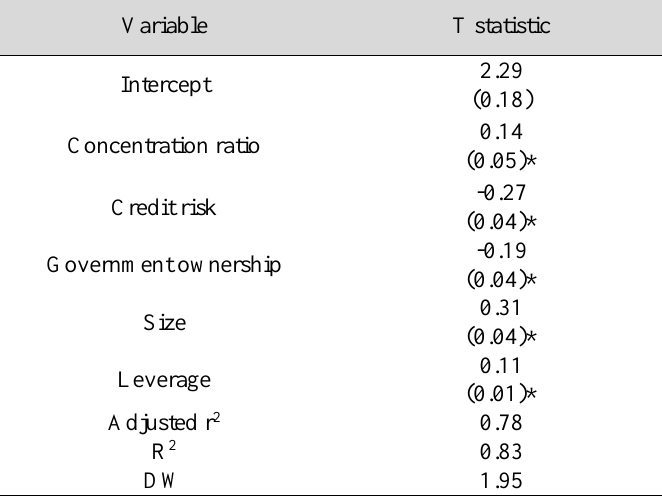
Table 6: Results of model estimation (dependent variable: capital adequacy